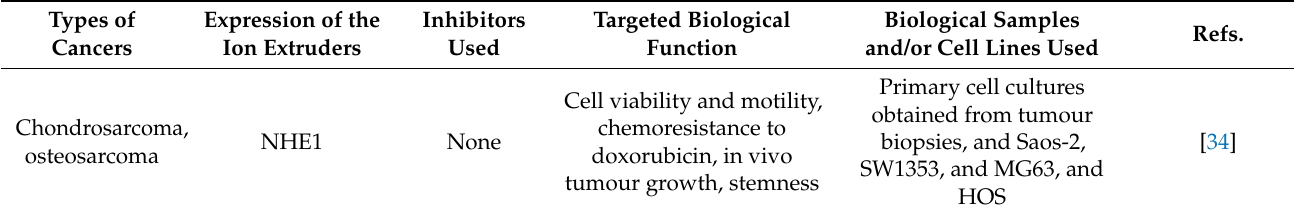
Table 4. NHE expression and targeting in bone